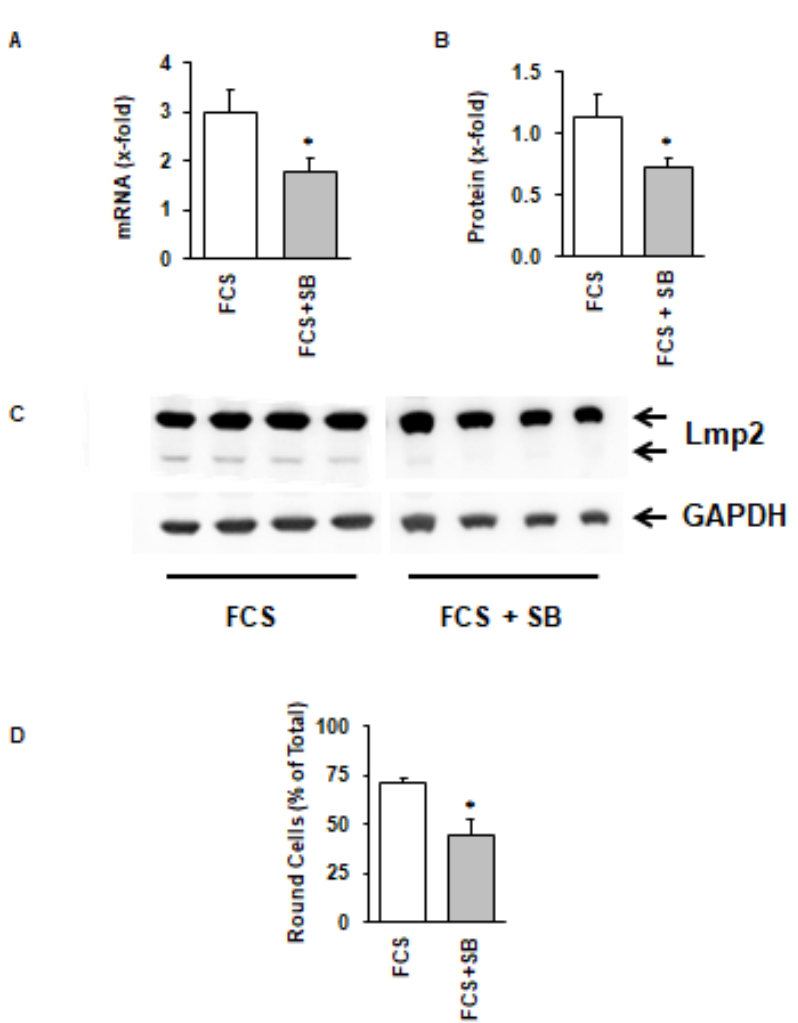
Figure 3. Cell size ( A – C ) of freshly isolated cardiomyocytes with one ( n = 1) or two ( n = 2) nuclei ( A , µ m length; B , µ m width; C , µ m 3 volume). Percent of cells to round down in the presence of fetal calf serum is shown in ( D ). Data are means ± SD from n = 11 preparations (96–304 cells per preparation). (*, p < 0.05 vs. FCS)